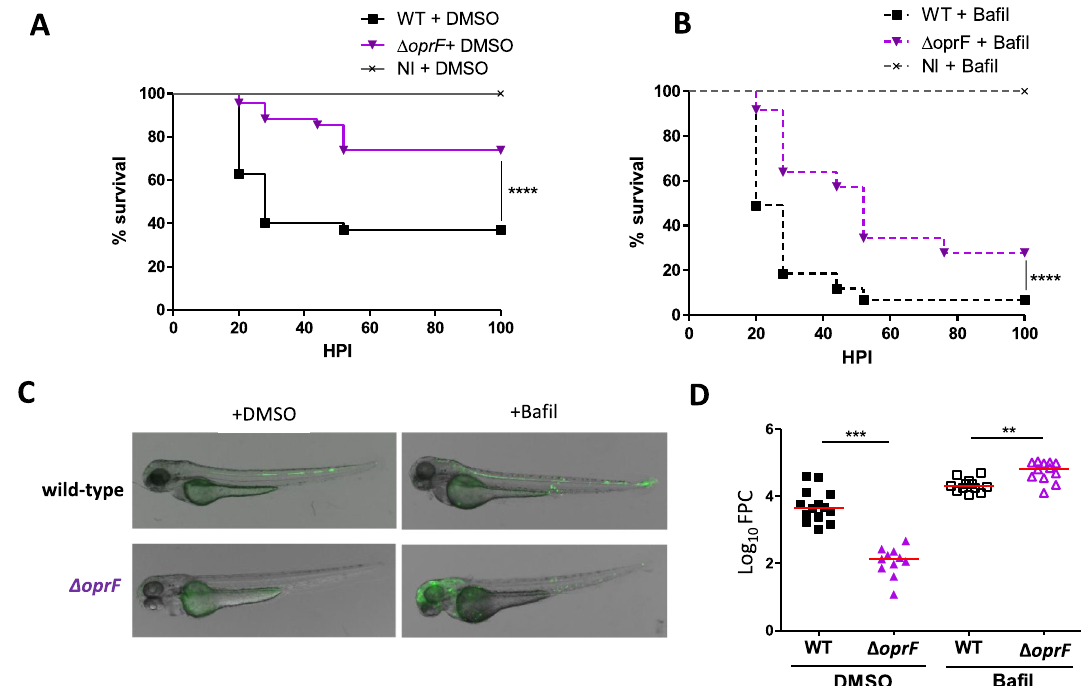
Figure 6. Effect of bafilomycin on the virulence of wild-type and Δ oprF mutant in zebrafish embryos. Embryos were infected with either wild-type or Δ oprF P. aeruginosa (2000–2500 CFU) in the hindbrain ventricle at 2 dpf or not infected (NI) (n = 60–70 for infected embryos and n = 45 for NI embryos, pool of three independent experiments). Survival curves of embryos treated with 50 nM bafilomycin (Bafil) ( B ) or treated with DMSO as control ( A ). Statistical significance was determined by log-rank test. Imaging ( C ) and quantification ( D ) of bacterial loads (fluorescence pixel counts) representative of two independent experiments at 20 hpi (n = 11–14). Each symbol represents individual embryo and horizontal lines indicate the median values. Statistical significance was determined by one-tailed Mann–Whitney’s